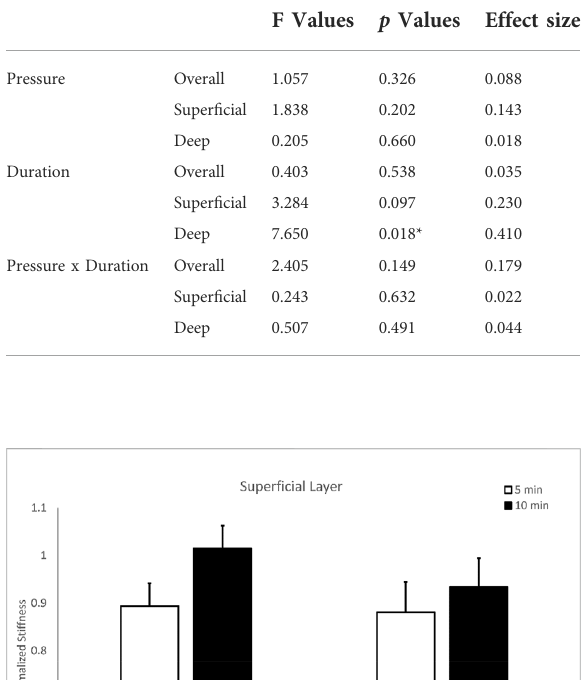
TABLE 2 Statistical results of the two-way ANOVA with repeated measures.